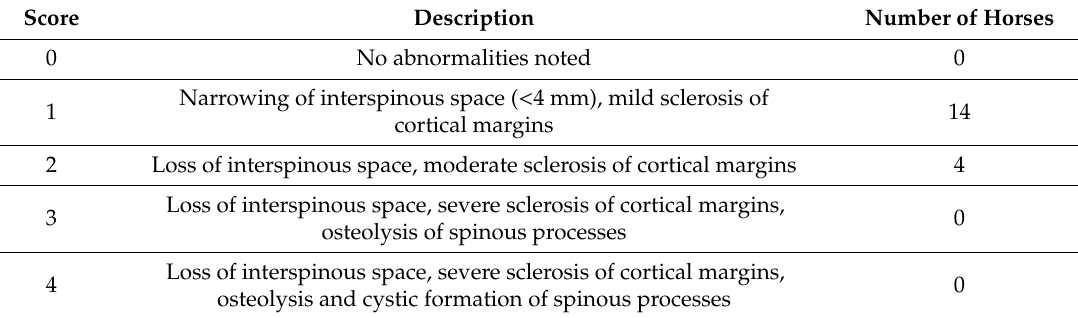
Table 2. Scoring of the radiographic findings (taken from